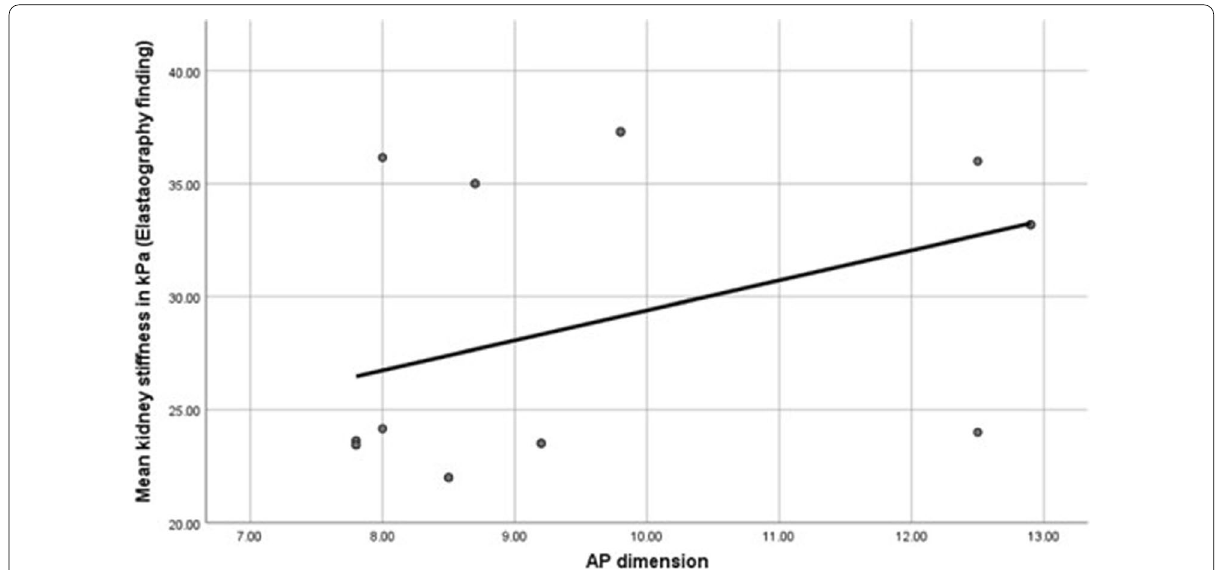
Fig. 5 Scatter plot showing the correlation between mean renal stiffness and antero-posterior